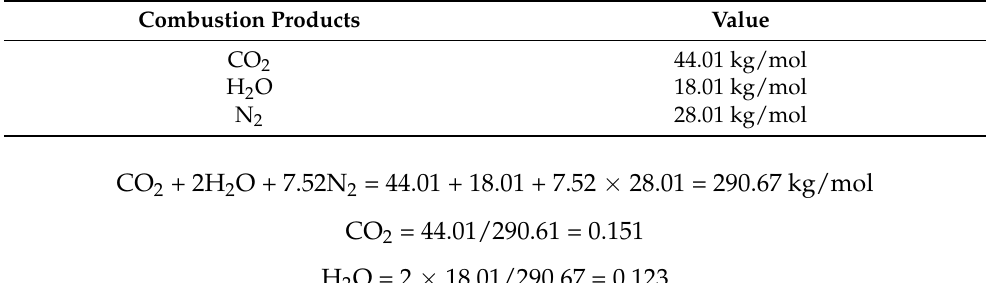
Table 3. Molar Mass of Combustion products.